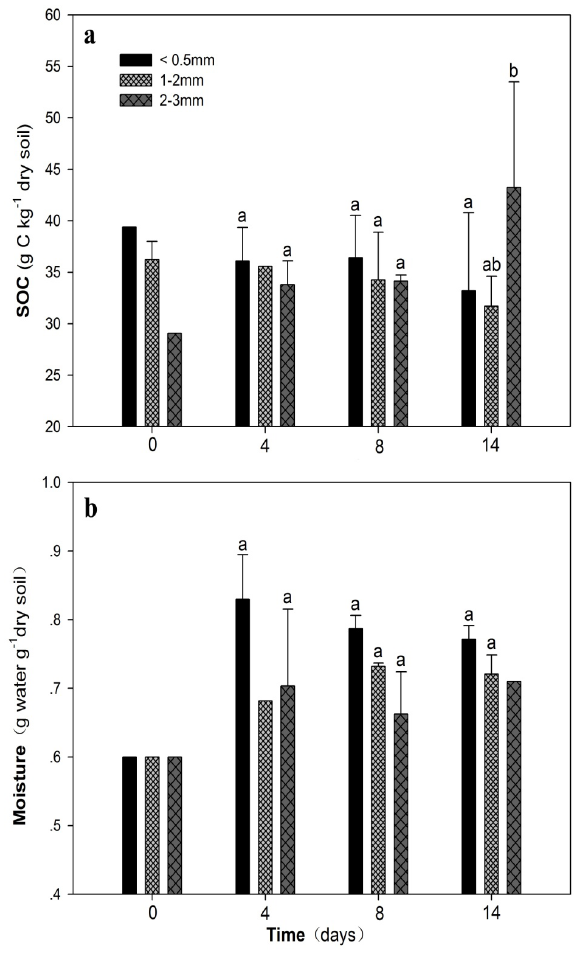
Figure 3: Variation of soil organic carbon (a) and moisture content